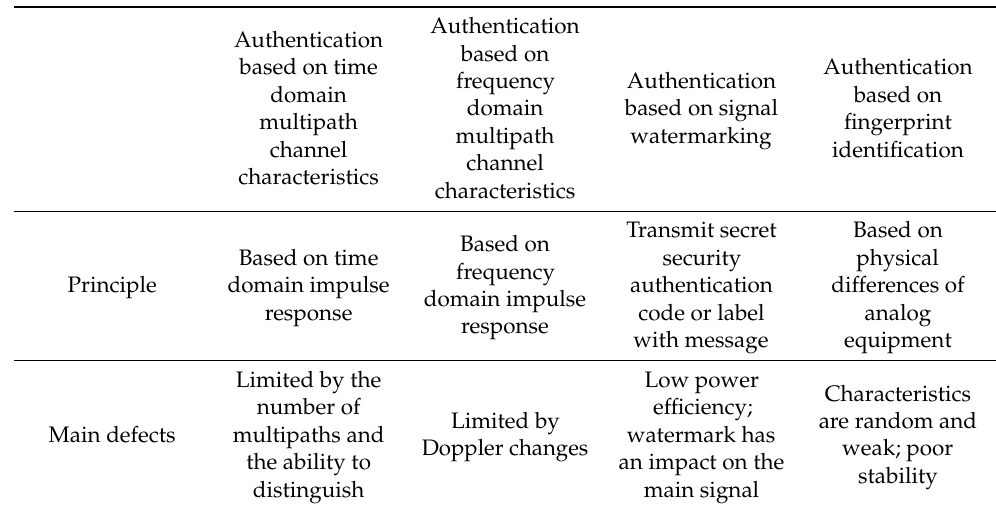
Table 1. Comparison of several authentication